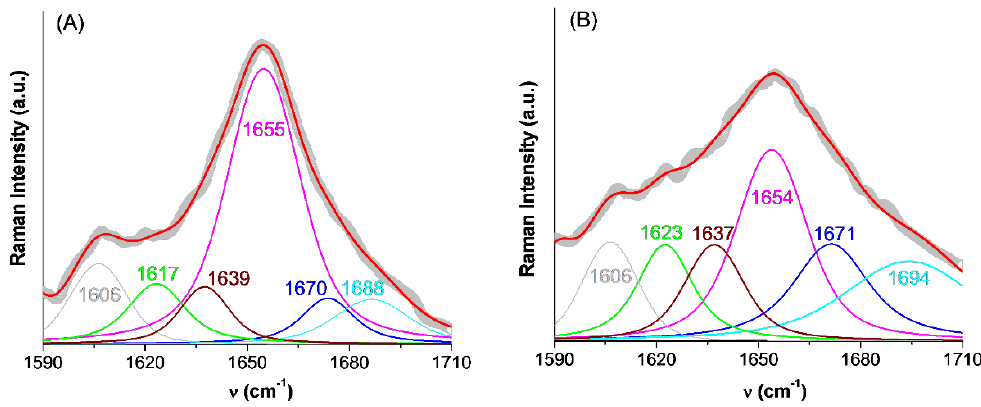
Figure 7. Deconvolution of the amide I region of the Raman spectra of free BSA ( A , day 1) and BSA adsorbed onto gold nanoparticles ( B , day 40). The secondary structure contents estimated from the respective peak areas are listed in Table 4. Table 4. Secondary structure content of BSA prior to and after gold nanoparticle formation and growth, as evidenced by Raman spectroscopy.